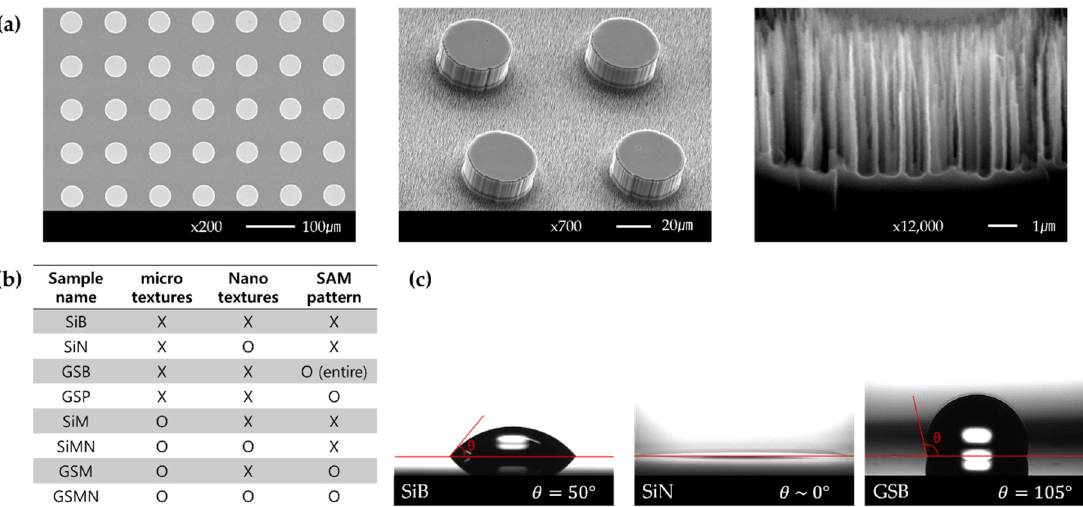
Figure 2. ( a ) The SEM images of micro/nanotextured surface. ( b ) The sample names by texture features. ( c ) The static contact angles of SiB, SiN, and GSB surfaces.